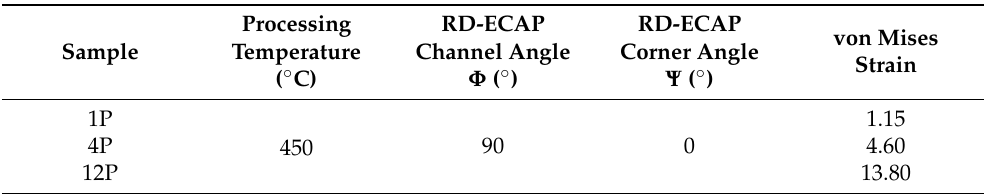
Table 2. Testing information and the related